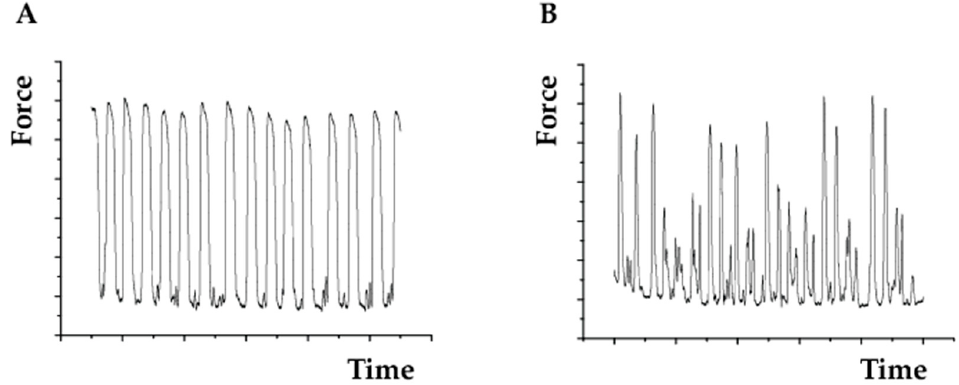
Figure 5. Example of beating recording for ( A ) a control cardiomyocyte cell and ( B ) a cardiomyocyte carrying the progeria mutation (c.1824 C >T, p.Gly608Gly).